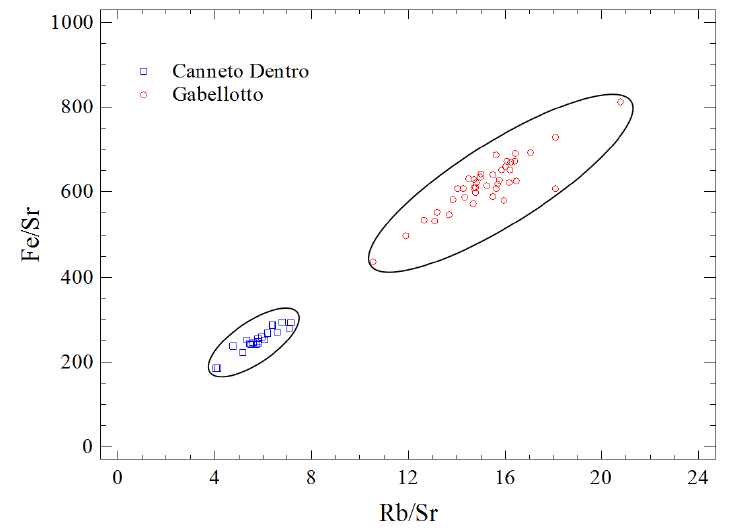
Figure 14. Element ratios for Canneto Dentro and Gabellotto Gorge by